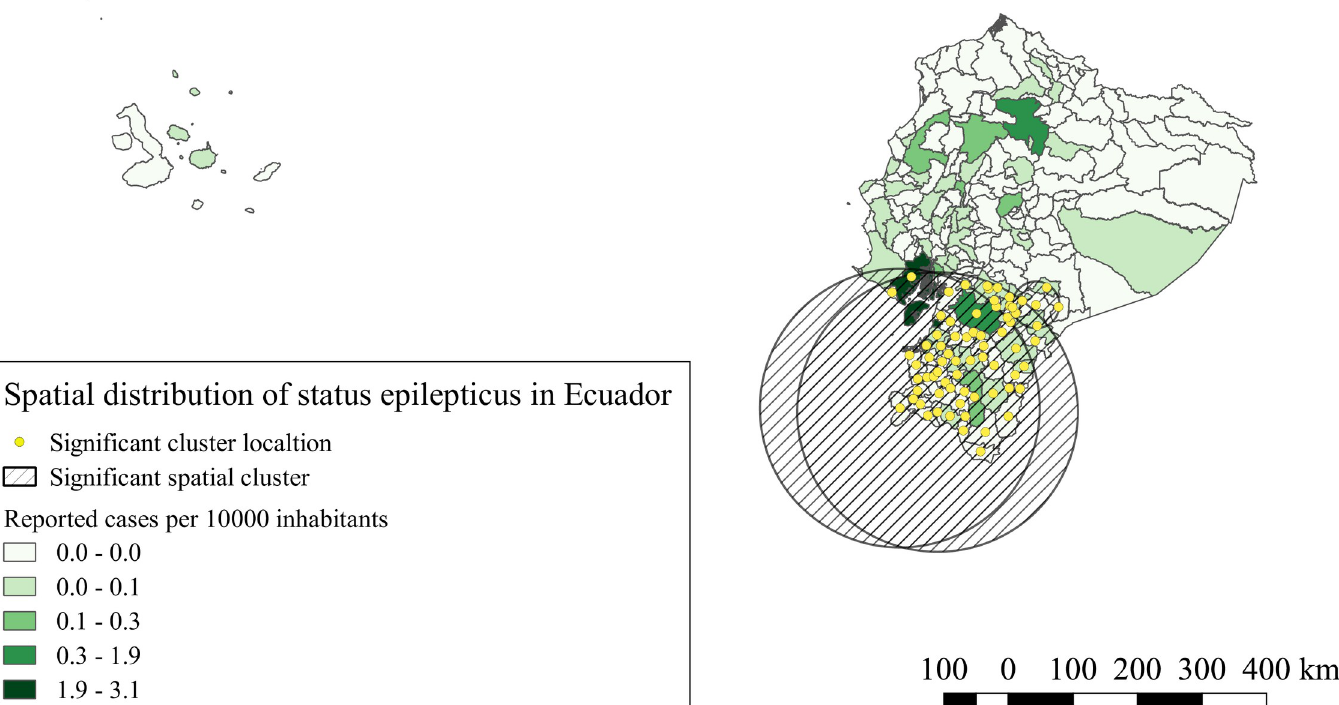
Fig 3. Spatial distribution and significant space clusters of status epilepticus hospitalized cases in Ecuador. Shape files for this map were obtained from INEC portal [51].